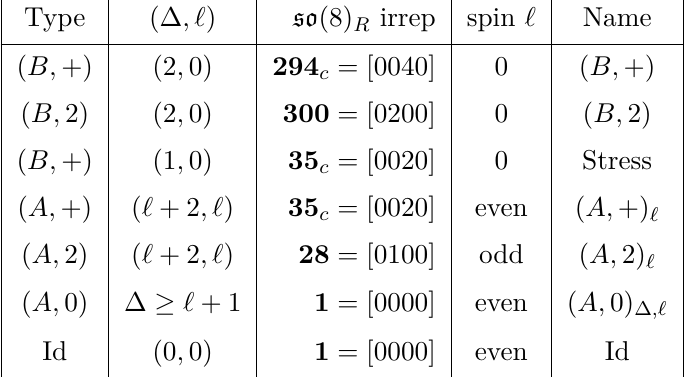
Table 1 . The possible superconformal multiplets in the O Stress ×O Stress OPE. The so (3 , 2) ⊕ so (8) R quantum numbers are those of the superconformal primary in each